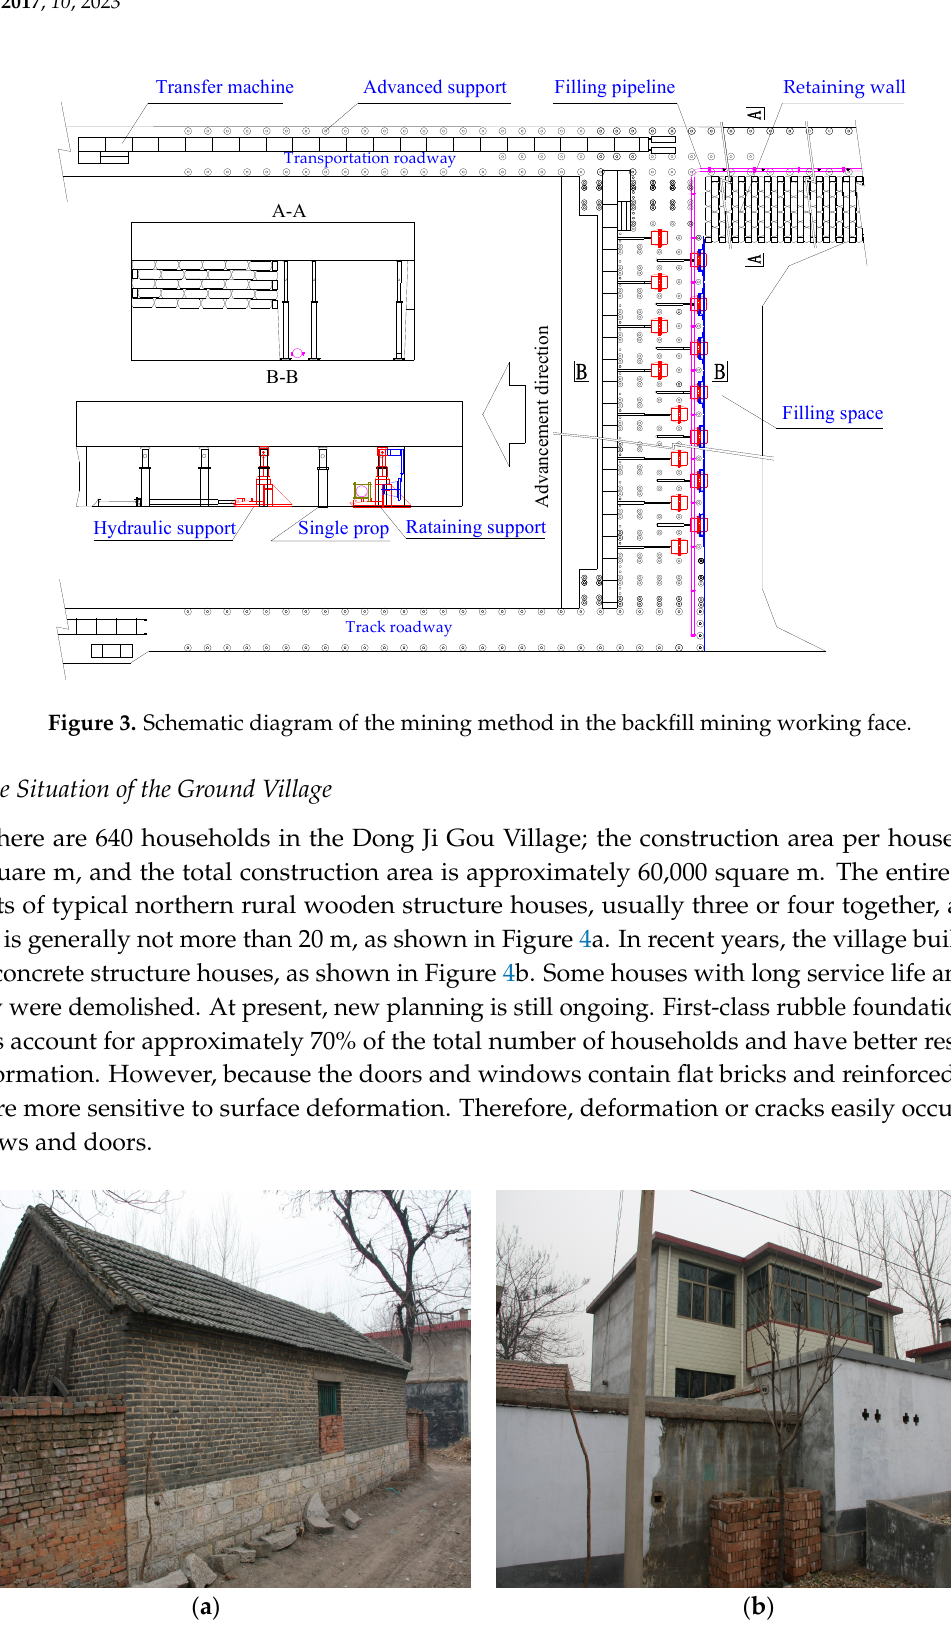
Figure 4. Buildings in the villages: ( a ) Northern rural wooden structure houses; ( b ) Brick-concrete structure building.